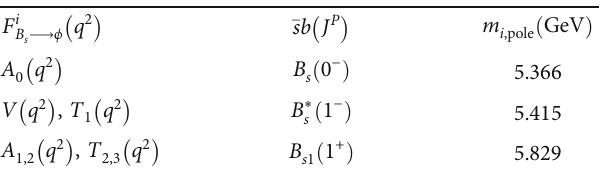
Table 5: The masses m ð q 2 Þ F i B s ⟶ ϕ